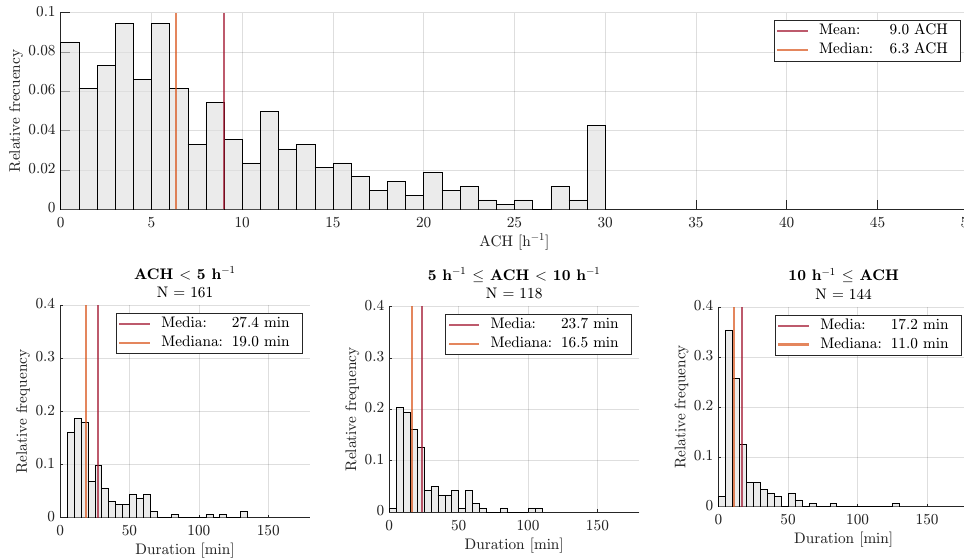
Figure 5. Distribution of adjusted ACH values for the afternoon shift during occupation hours ( above ) and duration of adjustment windows stratified by ACH ranges ( below ). N indicates the total data points for each